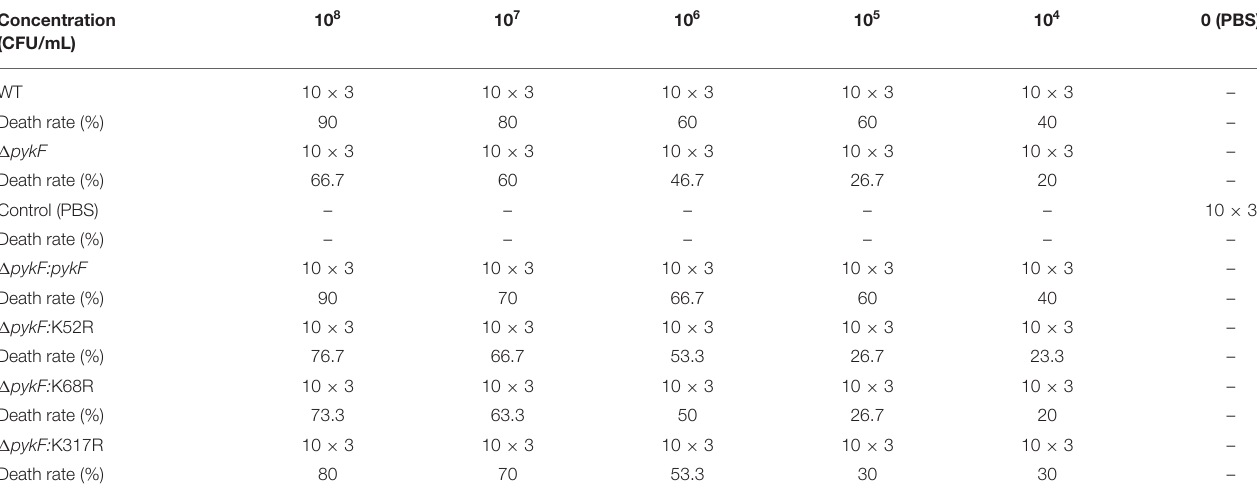
TABLE 3 | Experiment of LD 50 .